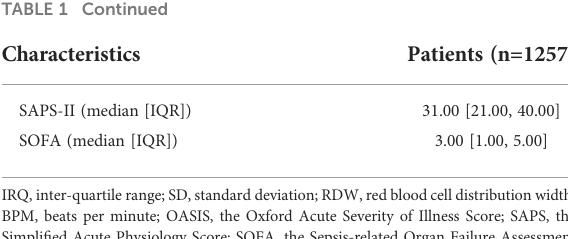
TABLE 1 Patient ’ s demographics and clinical